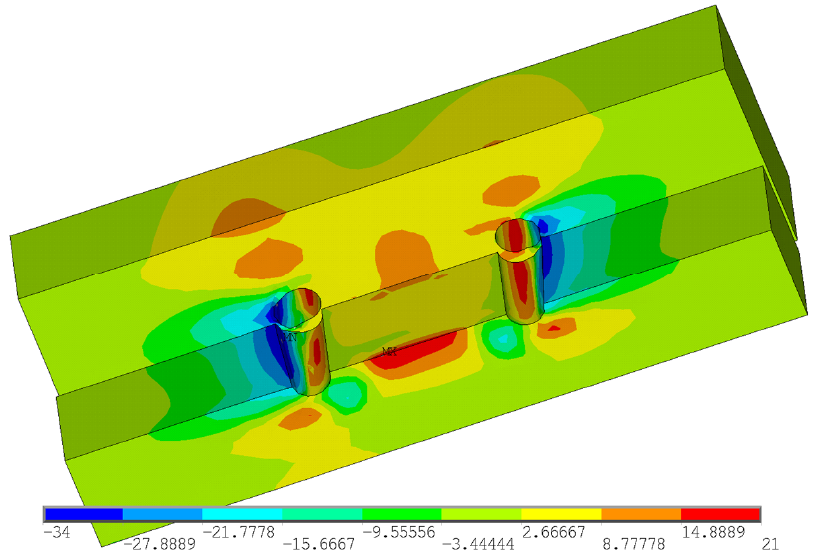
Figure 16. Normal stress in the X direction (tension and compression parallel to the grain).